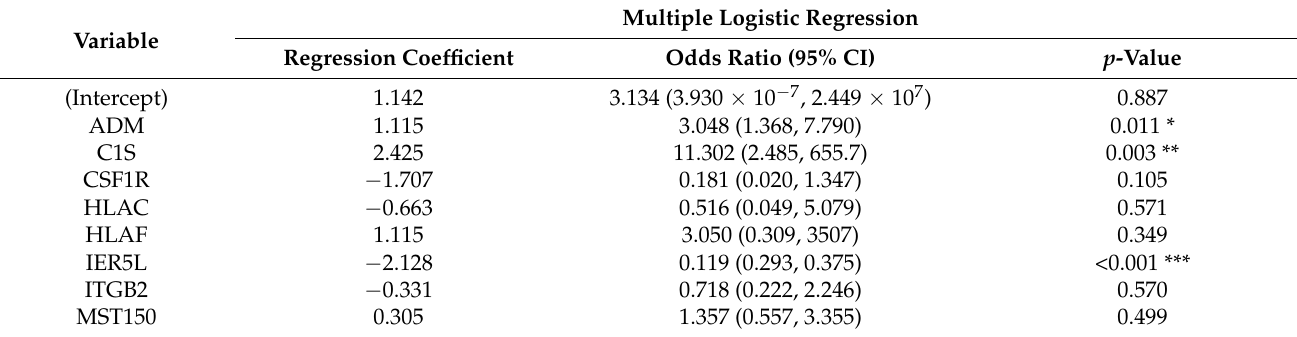
Table 1. The results of multiple logistic regression analysis.